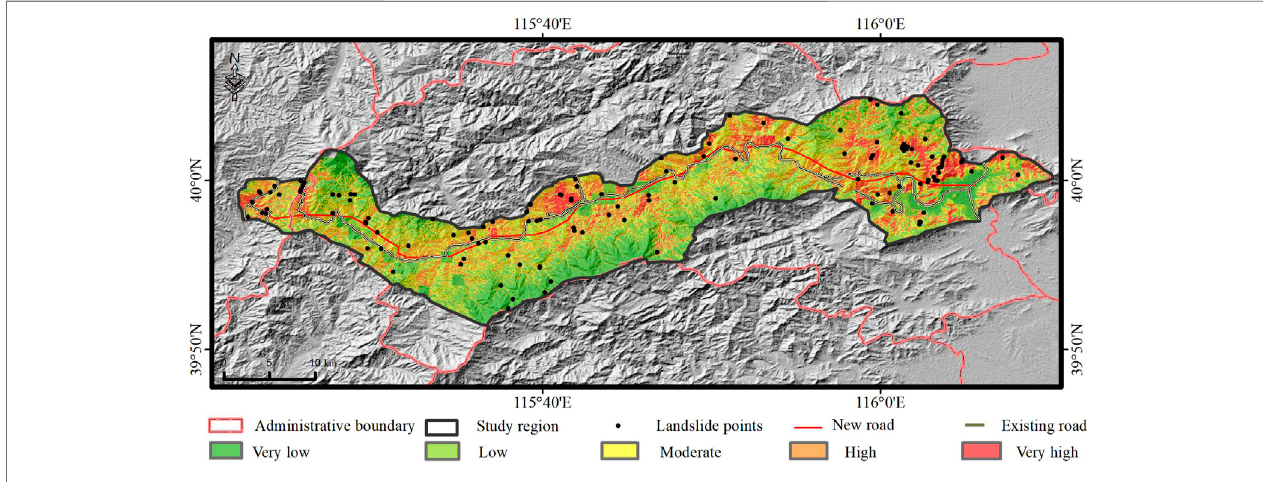
FIGURE 5 | Landslide susceptibility map.